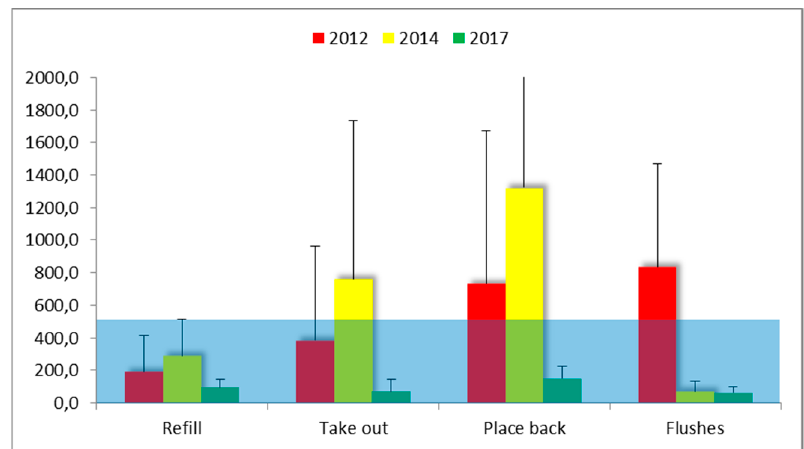
Figure 10. Mean ± sd FA concentrations (µg/m 3 ) in the breathing zone during specific tasks. The shaded area indicates the 15-min TWA OEL of 500 µg/m 3 for FA in the Netherlands. Refill = preparing a formalin solution from the 37% stock (storage room); Take out = searching and lifting of complete cadavers or parts from storage tanks (storage room); Place back = Immersion of complete cadavers or parts in a formalin solution in a storage tank after use (storage room). Flushes = Flushing to remove formalin from small specimens (embalming room). See Table 5 for more detailed descriptive statistics.